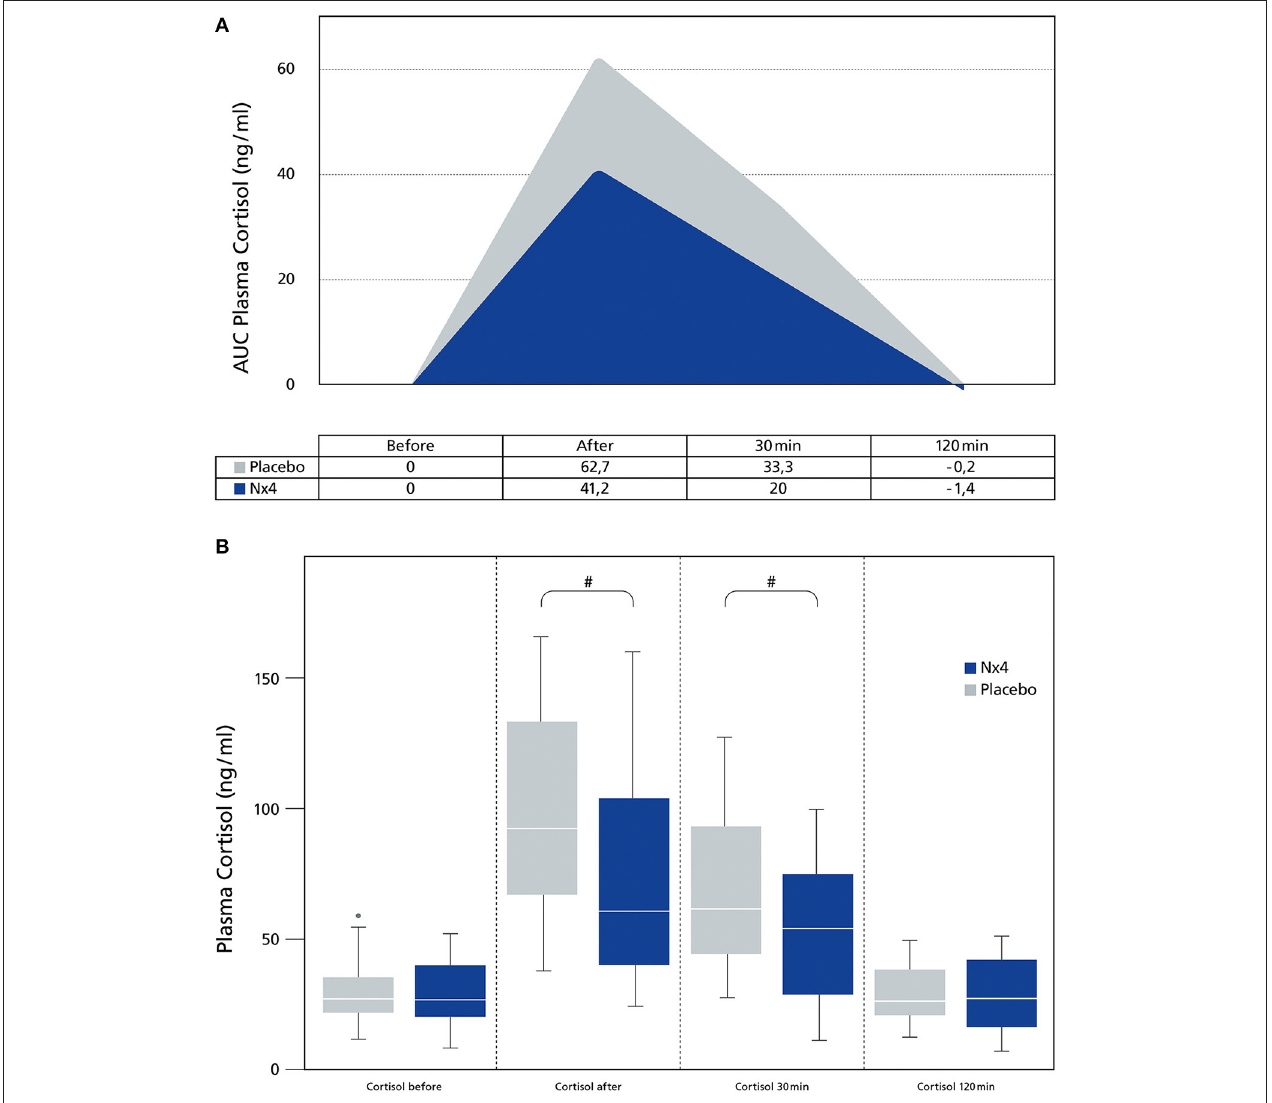
FIGURE 2 | Comparing plasma Cortisol (ng/ml) between dogs receiving Nx4 or Placebo at different time points. (A) The data ( n = 45), with 23 dogs in the Nx4 group and 22 dogs in the placebo group are displayed as boxplot showing the first (25%), the median (50%), and the third quartile (75%). The whiskers are displaying values within 1.5 times the IQR. Outliers are plotted as individual points. # p = 0.038, ## p = 0.047. (B) The data ( n = 45), with 23 dogs in the Nx4 group and 22 dogs in the placebo group are displayed as area under the curve. The area under the curve is the integral of a plot of the plasma cortisol (ng/ml) concentration against time. Since the baseline value (before exercise) had a significant influence, baseline was set to